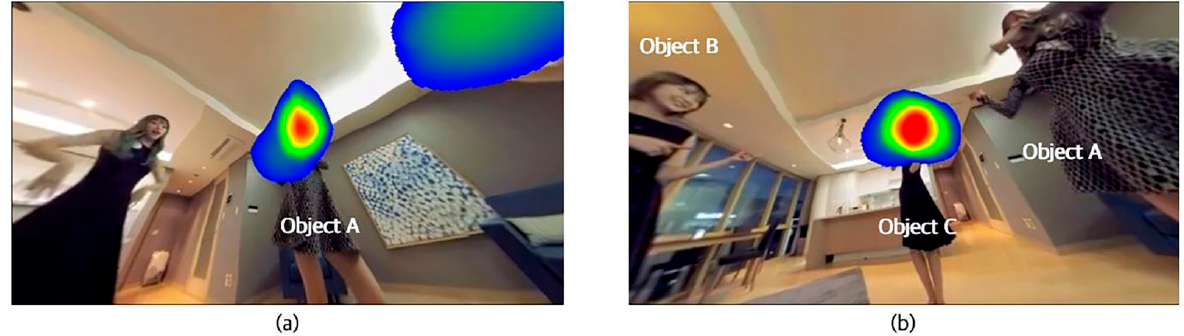
Figure 17. Eye movement according to attention-attracting element of “hand gesture”. ( a ) The subject focuses on object A, ( b ) The subject moves their attention to object C along with the gesture of object A and B.